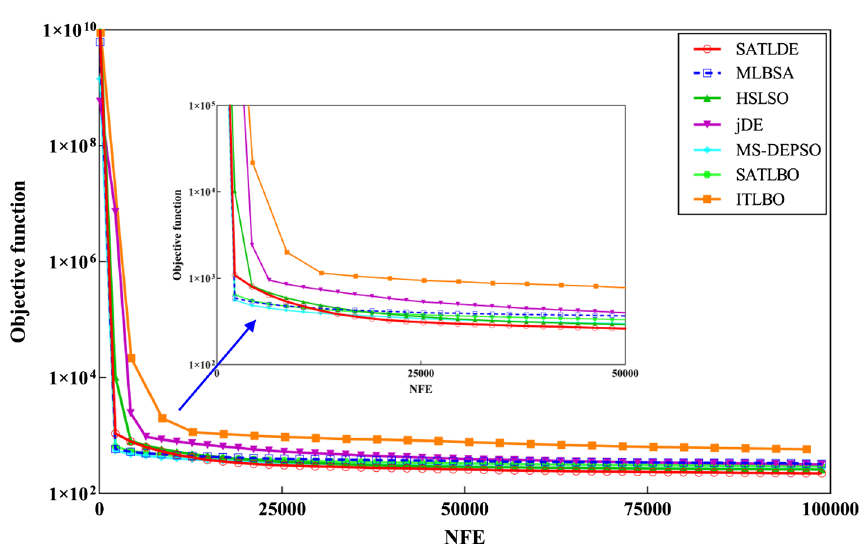
Figure 12. Convergence graphs of all optimizers for the multi-reservoir